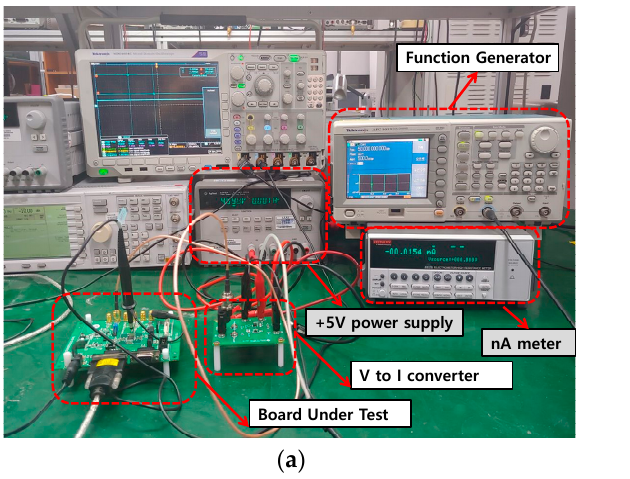
Figure 14. The measurement ( a ) equipment and ( b ) setup.